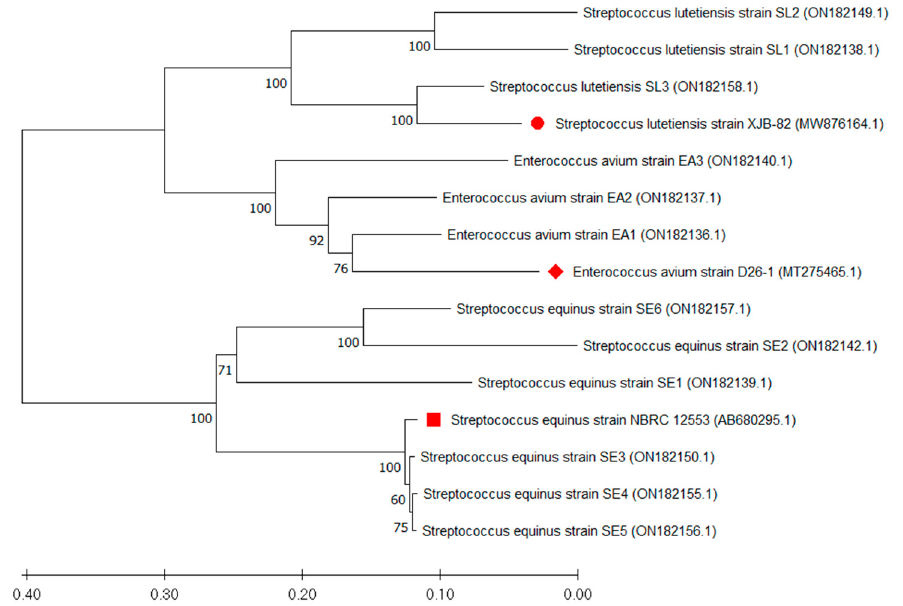
Figure 1. Neighbor-joining phylogenetic tree of strains of Enterococcus avium , Streptococcus lutetiensis and Streptococcus equinus . Red color indicates model strains.